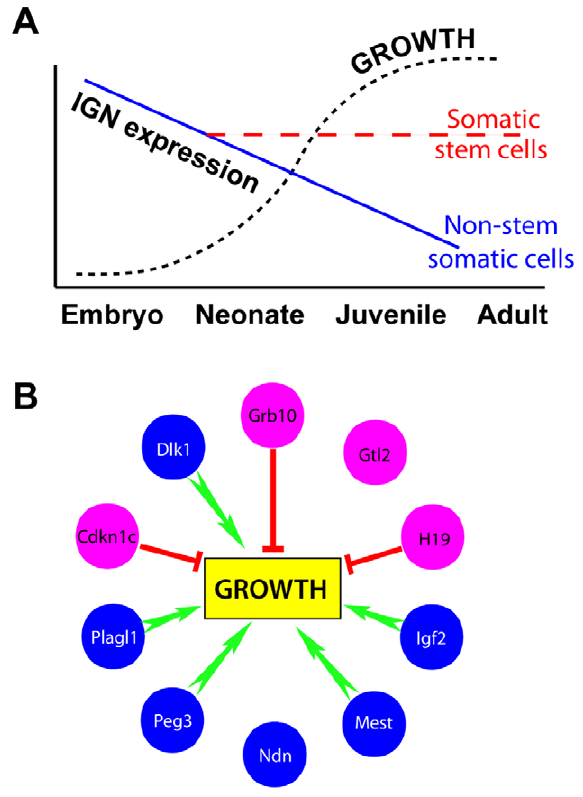
Figure 4. Models of IGN during development. (A) IGN members are highly expressed during embryogenesis but are downregulated in whole tissue as growth proceeds, while their expression is maintained in adult stem cell compartments. (B) Representation effects of the IGN on growth. Maternally expressed genes are depicted in pink and paternally expressed genes in blue. Overall effect on growth as determined by transgenic or knockout animal models is shown in green (promotion) or red